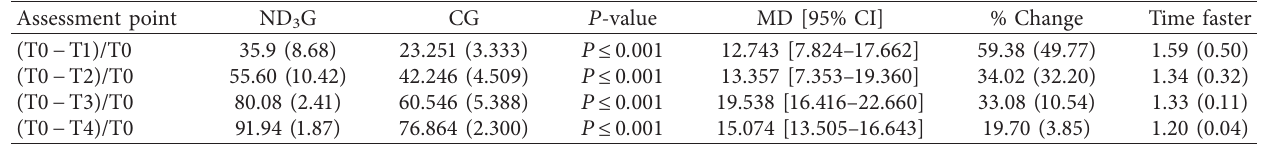
Table 4: Improvement percentages between